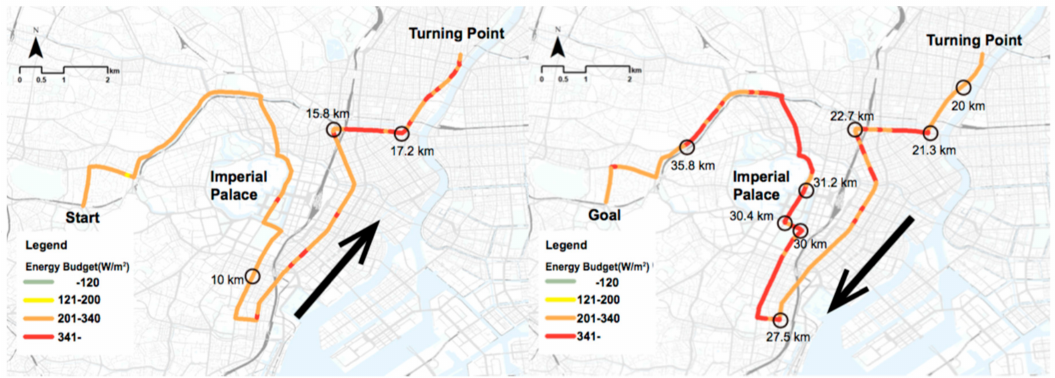
Figure 3. Energy budget for August 9, 2016 mapped on the marathon route (left: outward; right: homeward).